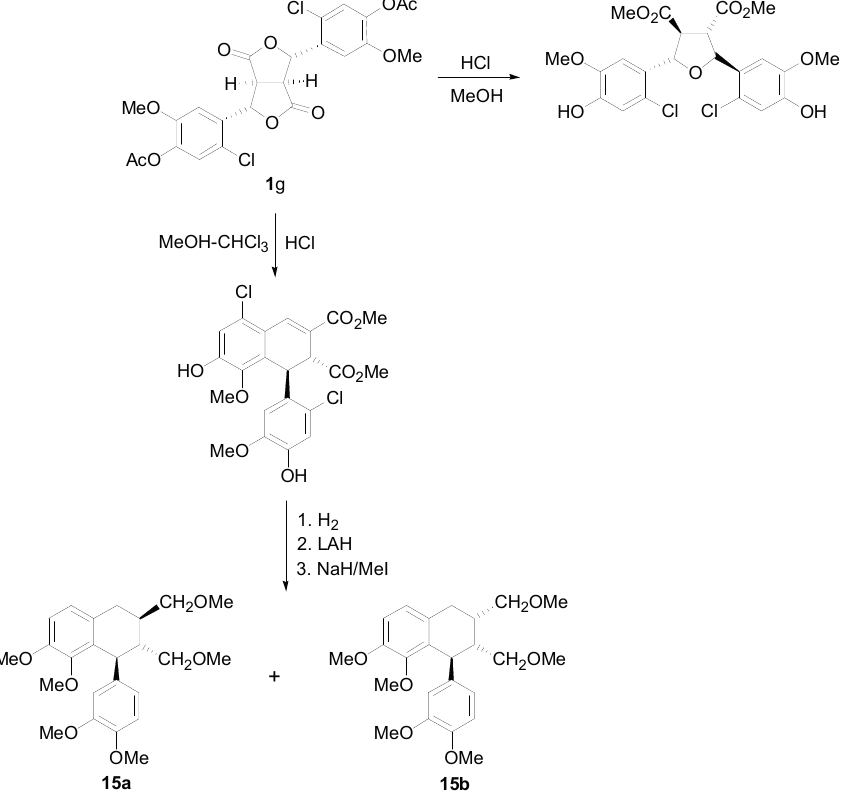
Scheme 11. Application of halogenated lactone 1g to the synthesis of lignans of the CL3 subtype with a different oxygenation